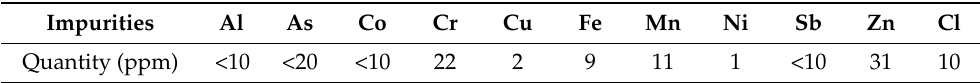
Table 1. Impurities in MgZr (data supplied by